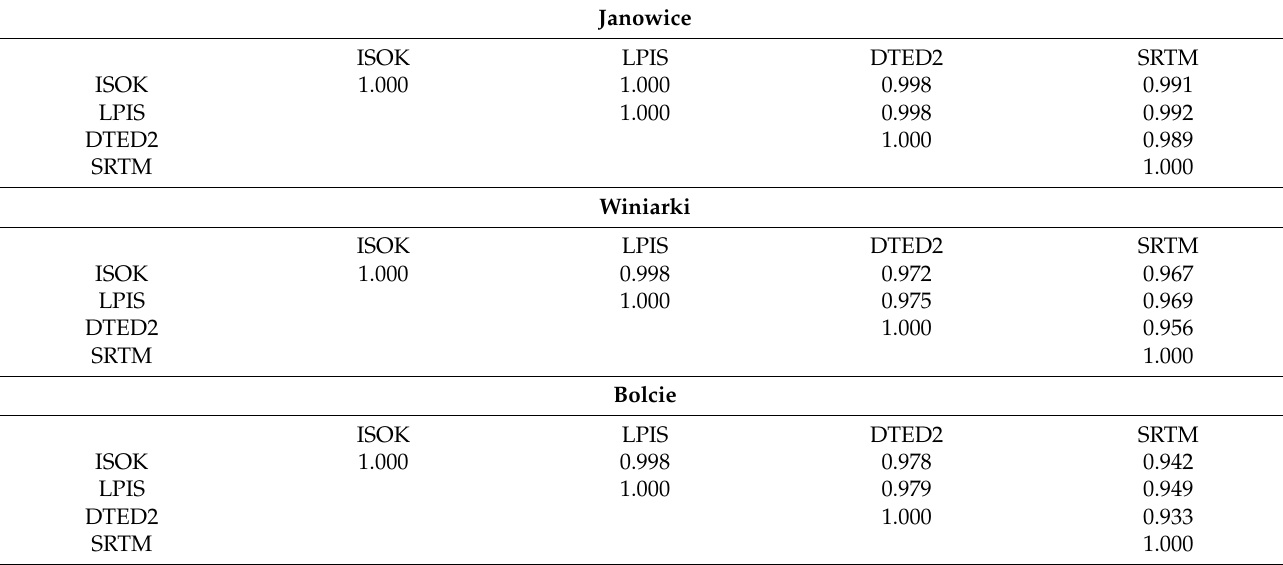
Table 4. Comparison of the DTM Pearson correlation coefficient values for all DTM sources in the 3 research areas.